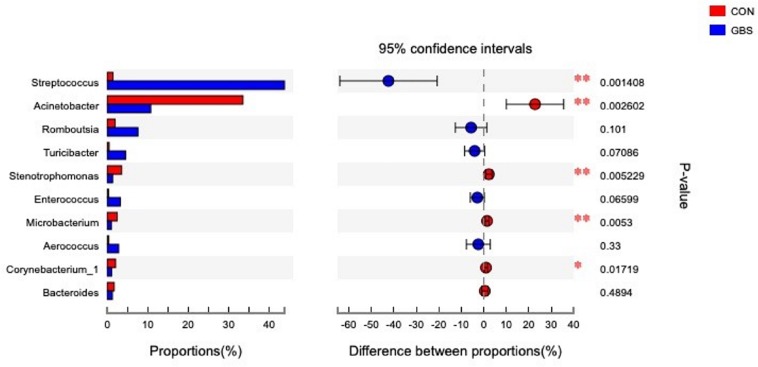
Differences between the relative abundance of the 10 predominant bacterial genera in milk samples from healthy cows (CON) and cows with S. agalactiae mastitis (GBS), n = 6. The extended error bar plot was generated using STAMP software. Welch’s two-sided test was used, and Welch’s inverted test was 0.95.